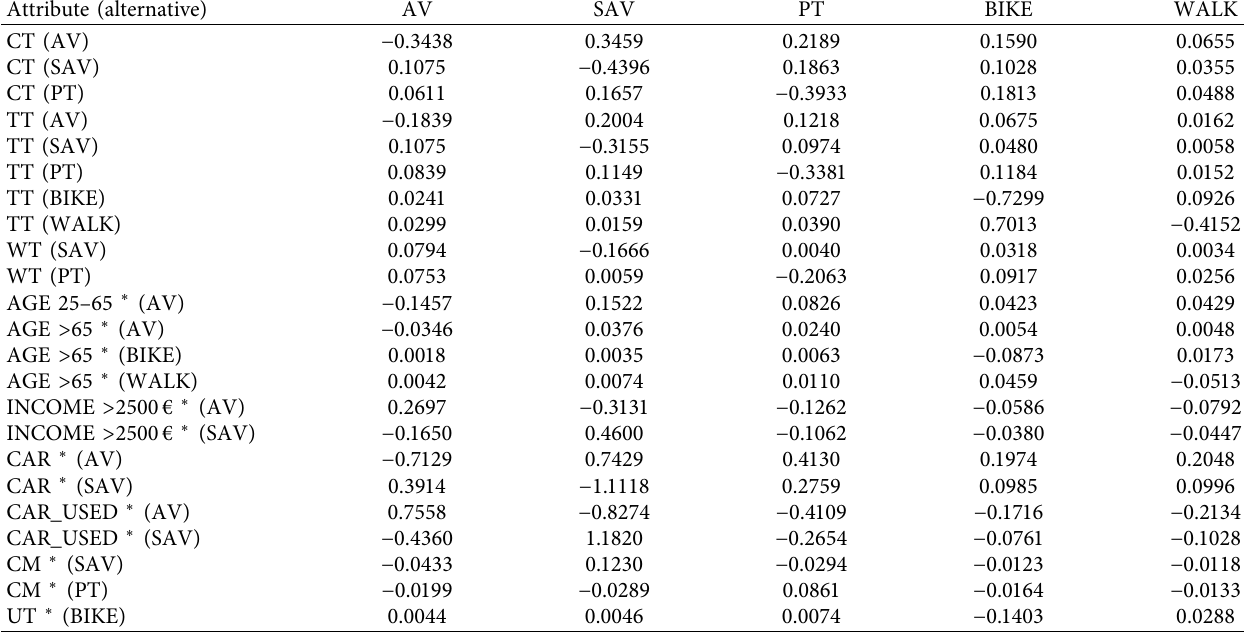
Table 6: Direct and cross point and arc elasticities for the ECML—mandatory trip model.